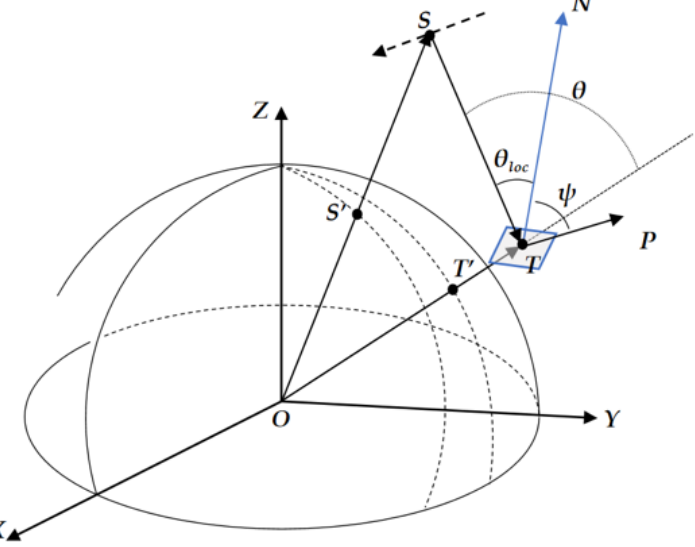
Figure 4. Local geometry of SAR imaging in an earth-centered rotating (ECR) coordinate